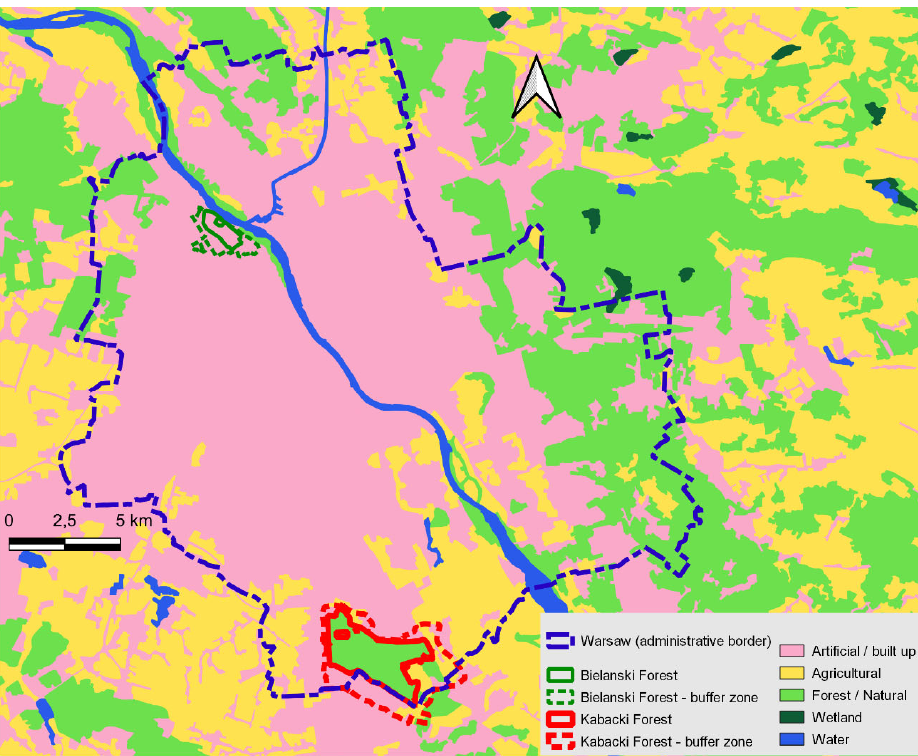
Figure 4. Bielanski and Kabacki Forests in Warsaw in the land use context.